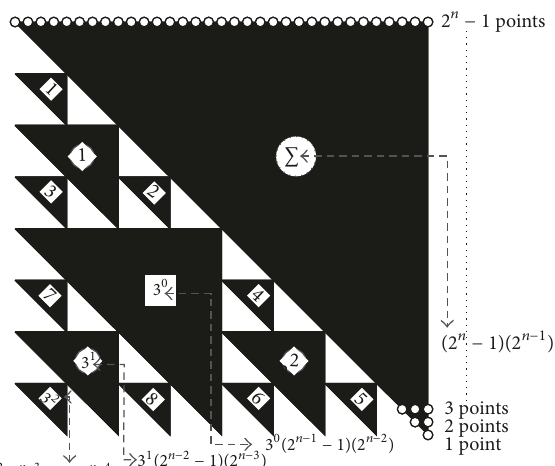
Figure 9: Total number of “redundant points”/the points in the darkened region, by counting the number of points in constituent triangles